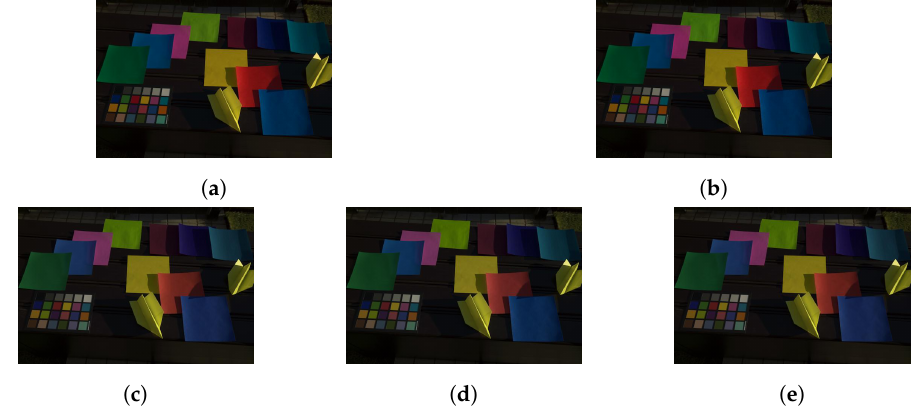
Figure 9. Images adjusted from Figure 7c. ( a ) WB (XYZ), ( b ) WB (von Kries), ( c ) 3CB (6, 9, 14), ( d ) 3CB (11, 14, 24), and ( e ) Cheng